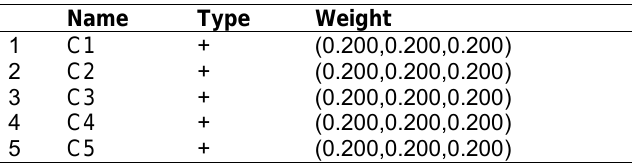
Table 2. Characteristics of